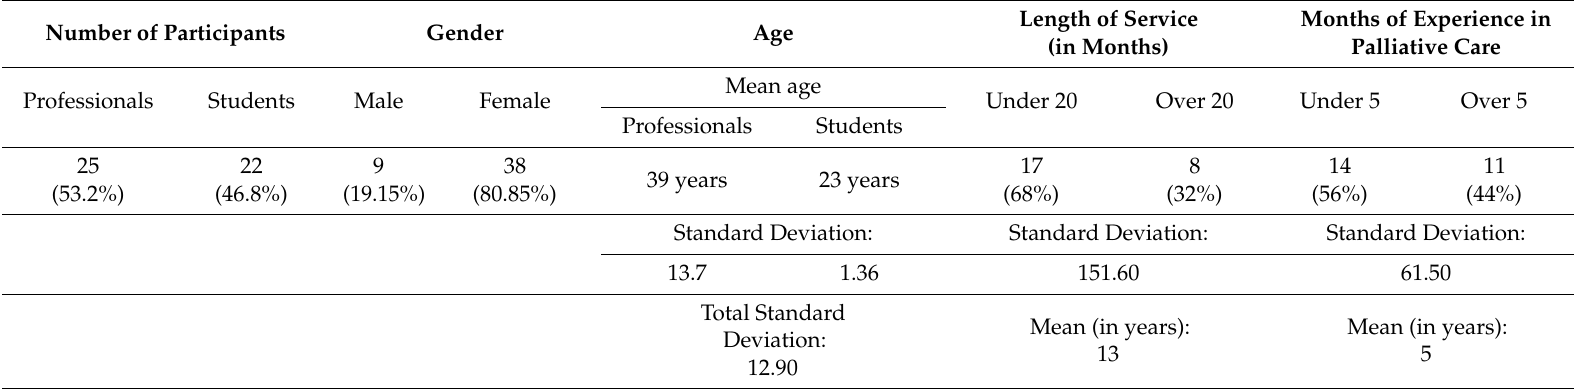
Table 1. Participants: Nurses and